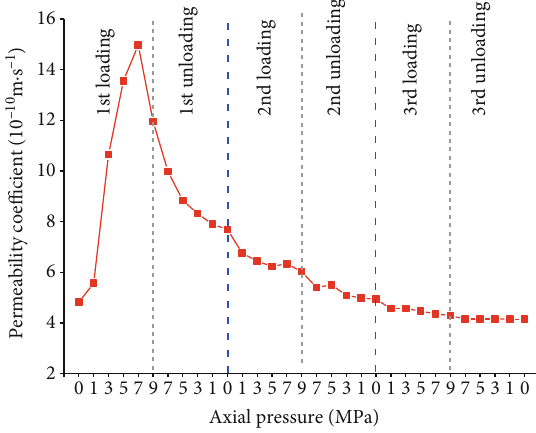
Figure 13: Variation of permeability coe ffi cient under the full-path of loading-unloading the axial stress for fractured